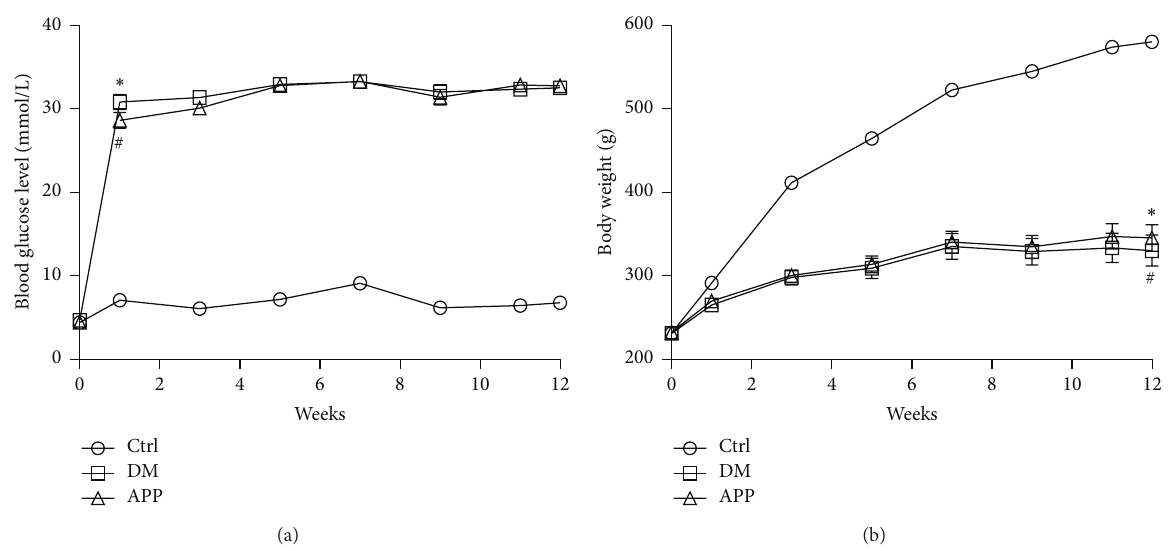
Figure 1: The blood glucose levels and body weights of the rats in Ctrl ( 𝑁 = 6 ), DM ( 𝑁 = 6 ) and APP ( 𝑁 = 6 ) groups. ∗ Significant difference between diabetic rats (both in DM and APP group) and control rats ( 𝑃 < 0.05